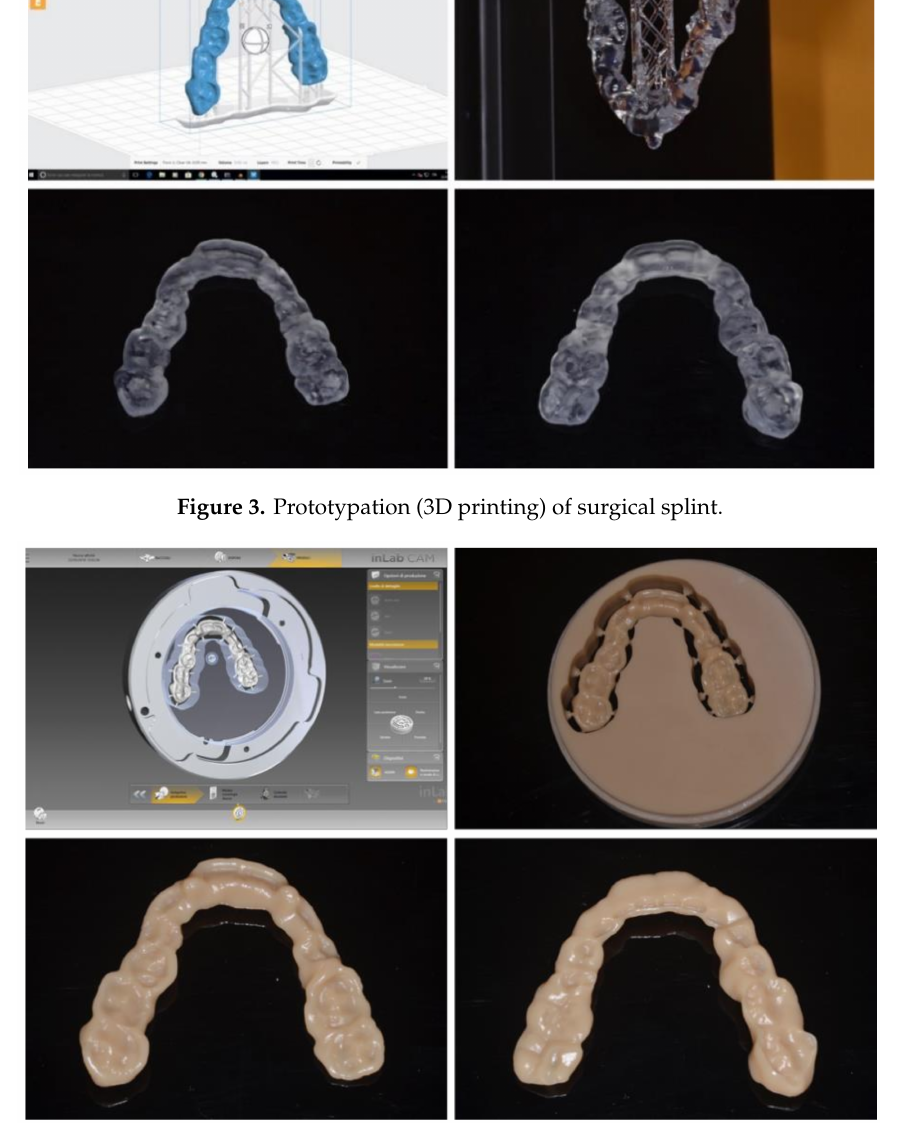
Figure 4. Surgical splint obtained from the milling